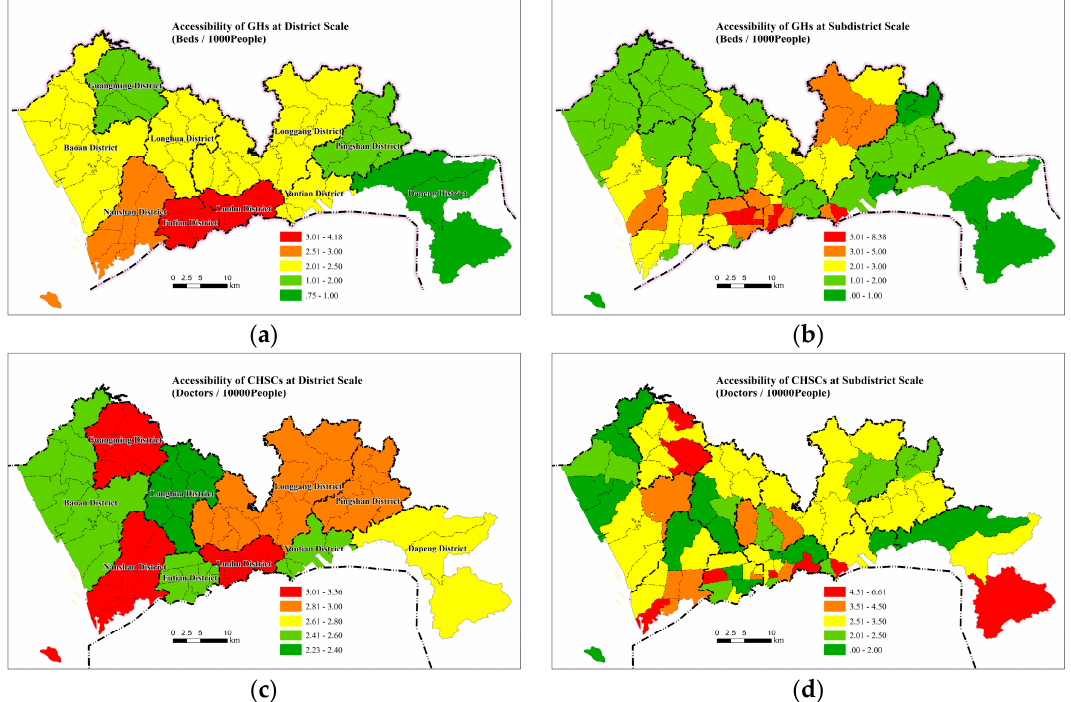
Figure 2. Spatial accessibility of GHs and CHSCs. ( a ) Spatial accessibility of GHs at district scale; ( b ) Spatial accessibility of GHs at subdistrict scale; ( c ) Spatial accessibility of CHSCs at district scale; ( d ) Spatial accessibility of CHSCs at subdistrict scale.